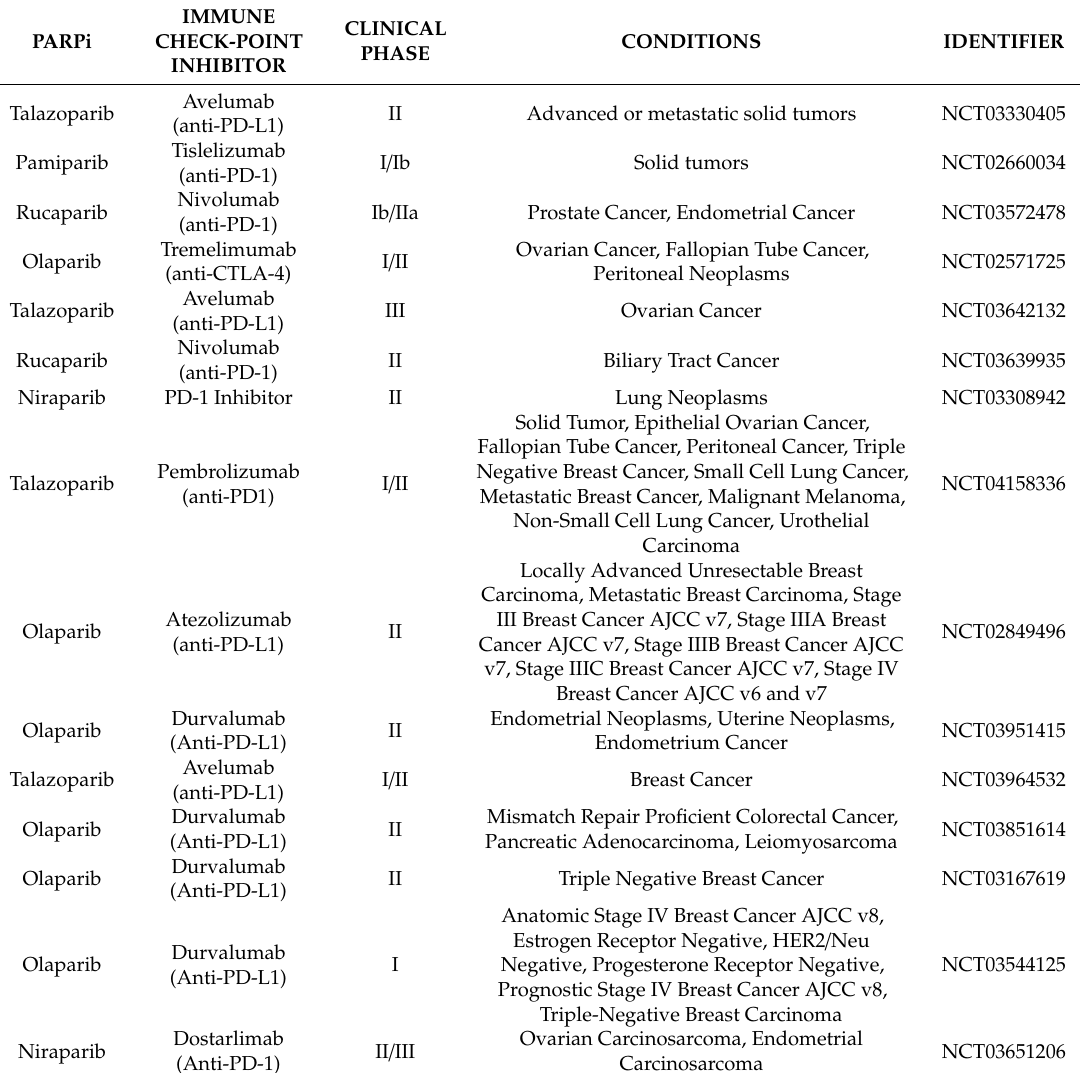
Table 2. Clinical trials with PARP inhibitors in combination with check-point blockade agents